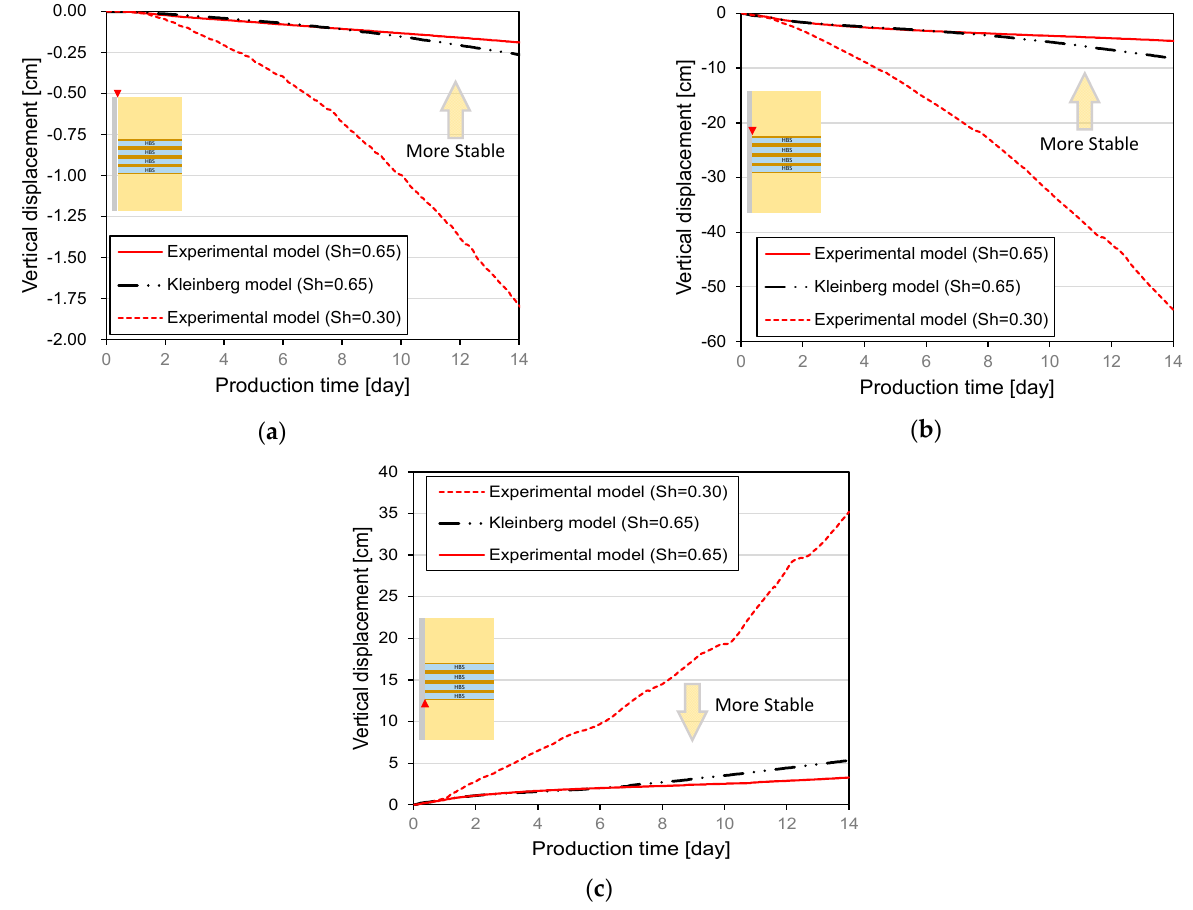
Figure 11. Subsidence and heave of sediment near the production well: ( a ) subsidence on sea floor; ( b ) subsidence at production well head; ( c ) ground heave at production well bottom.